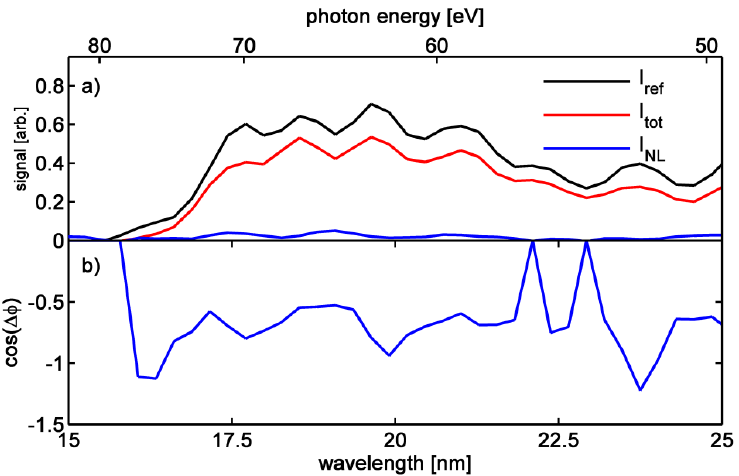
Figure 4. ( a ) Intensities of the permanent grating (I ref ), the total diffraction with permanent and transient grating (I tot ) are deduced from the raw scattering images as in Figure 2 by subtracting an exponential fit to account for the scattering background. The intensity of the transient grating only (I NL ) is directly measured by driving the permanent grating out of the beam. The heterodyned signal I tot is about one order of magnitude larger than the nonlinear signal; ( b ) Using Equation (1) we calculate the value for cos(Δϕ), showing the negative